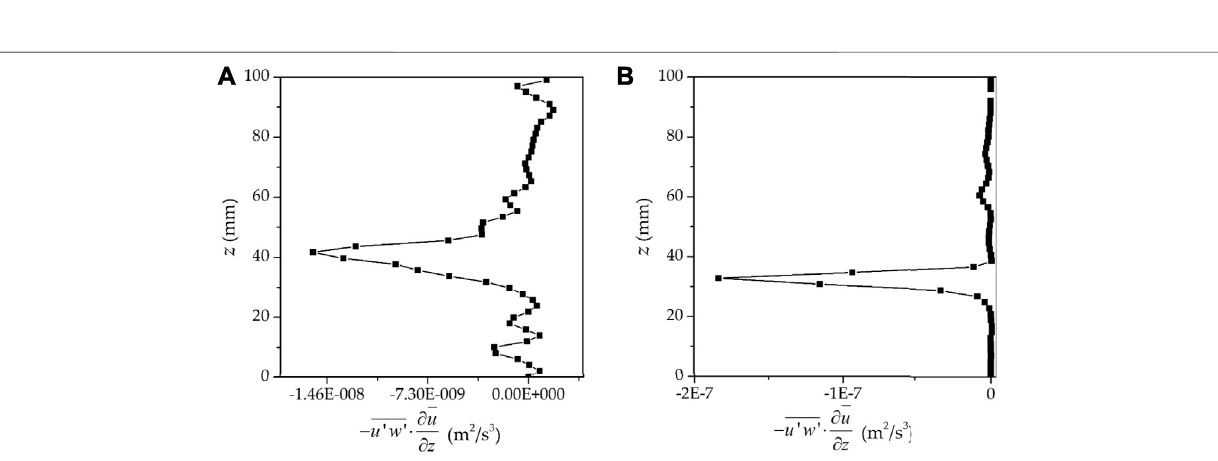
Frontiers in Environmental Science |